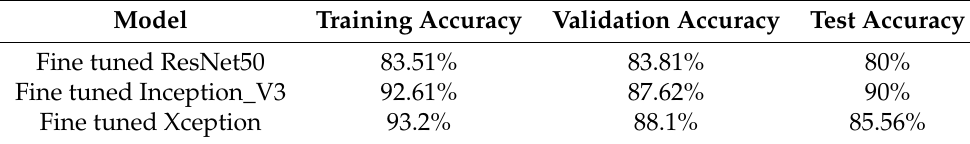
Table 5. Results of training deep learning models for image classification: Round-3